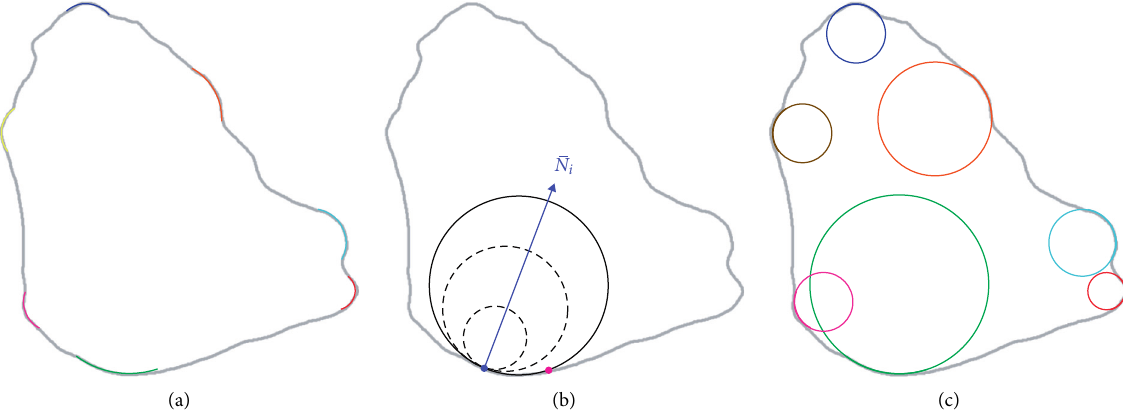
Figure 11: (a) Corner region of the particle contour, (b) determining the inscribed circle of a corner point, and (c) optimal inscribed circles of all corners.